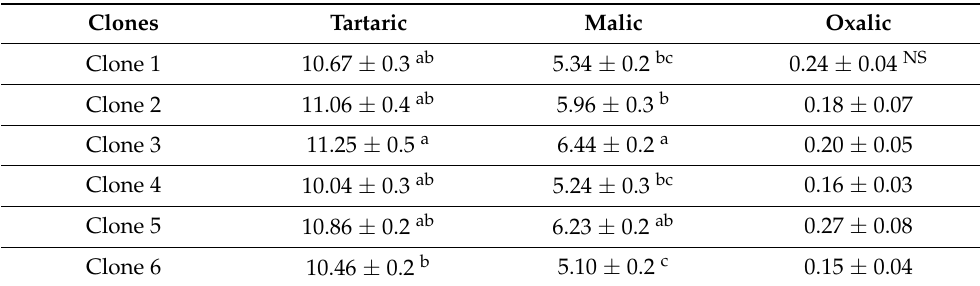
Table 7. Organic acid content (g/100 g FW) in juices of six ‘Köhnü’